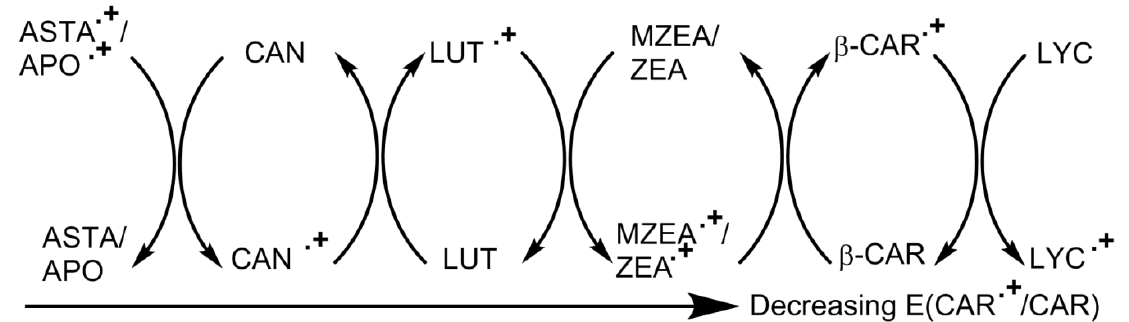
Figure 6. Scheme showing the relative ordering of the one-electron reduction potentials of several carotenoid radical cations in benzene.